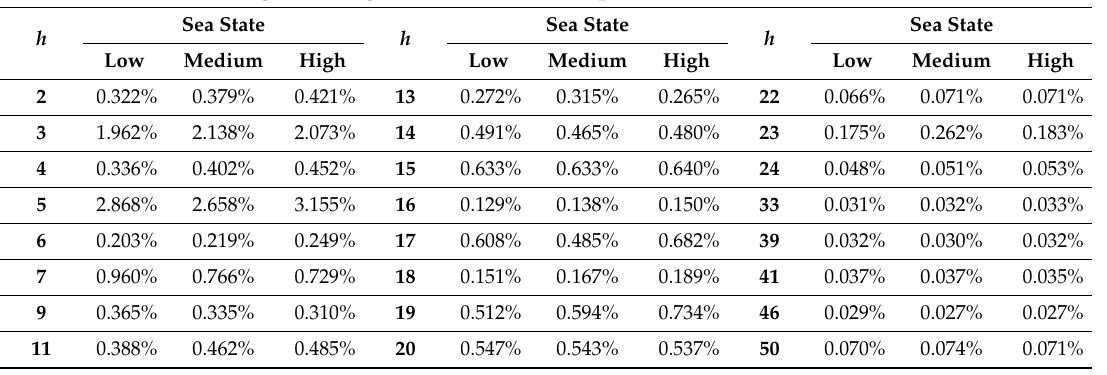
Sea trial average reportable ratios of harmonic current amplitudes for each resource classification.